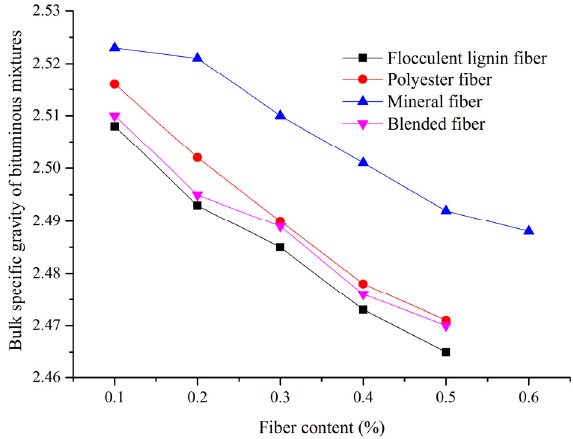
Figure 2. Bulk specific gravity of SMA mixtures with four different fibers.